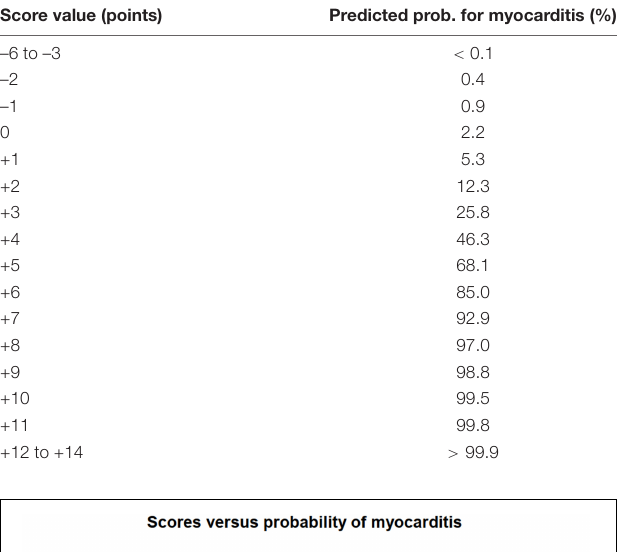
TABLE 4 | Predicted probabilities for myocarditis for each sum of score points.